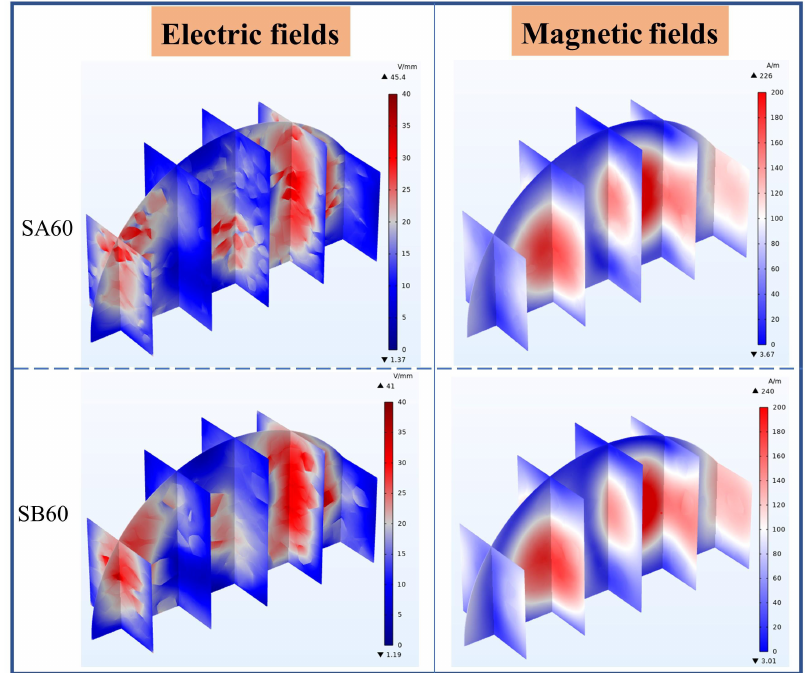
Figure 7. The multi-section of the electromagnetic field of SA60 and SB60.